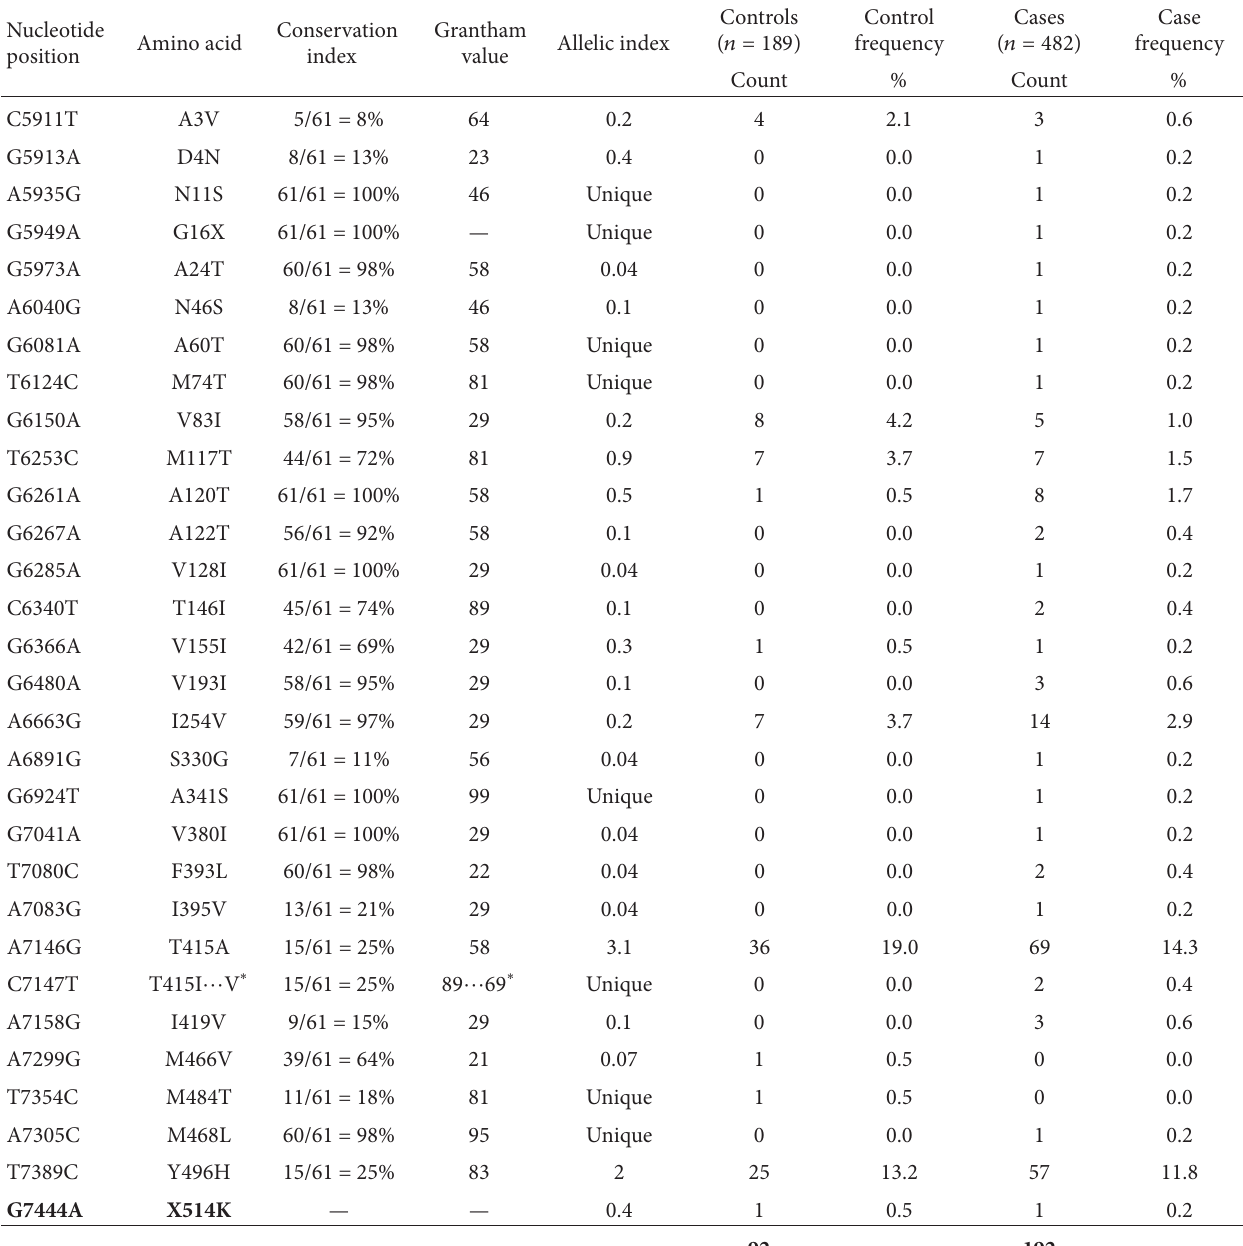
T 2: Missense mutations in Caucasian and African American cases and controls.